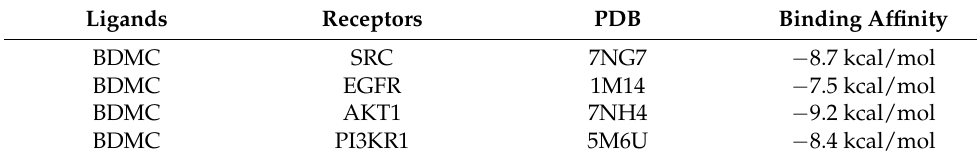
Table 1. Molecular docking of BDMC binding energy results for UC major targets.